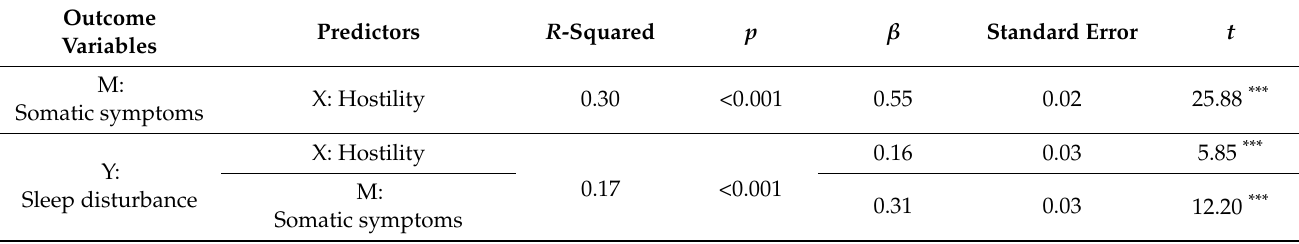
Table 4. The mediating effect test of somatic symptoms.